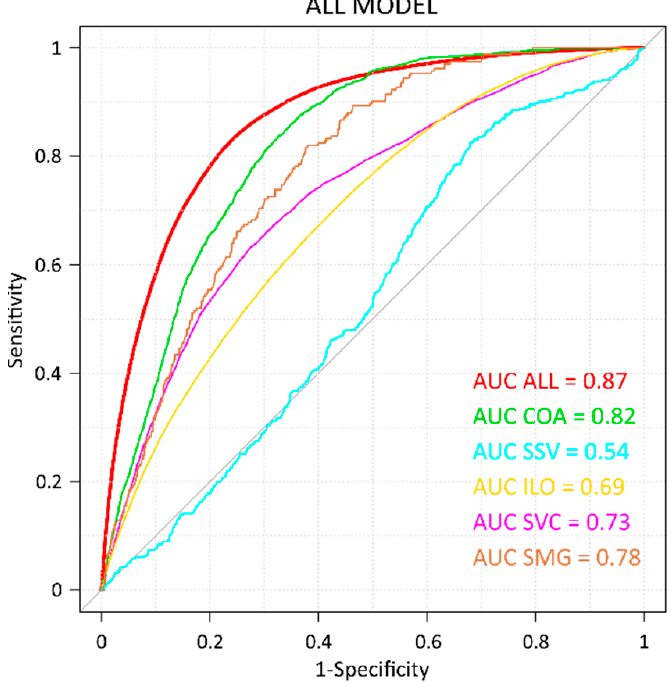
Figure 2. ROC plots and relative AUC values for the ALL models.